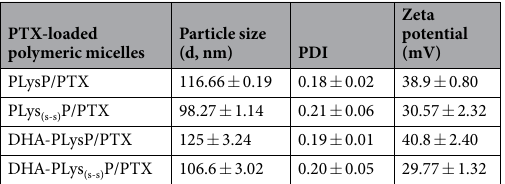
Table 1. Particle size, polydispersity index and zeta potential of PTX-loaded polymeric